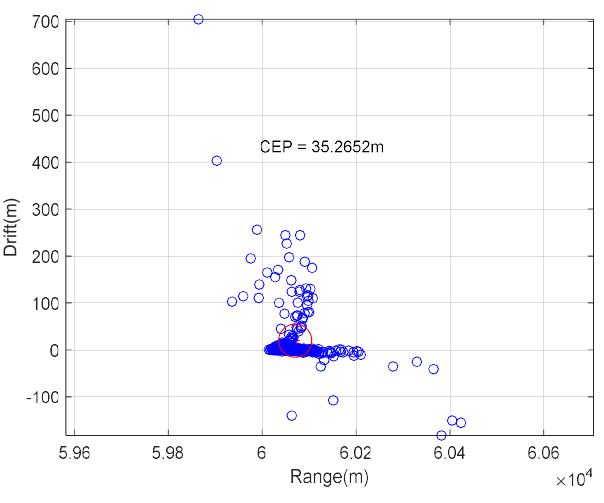
Figure 26. Guided Rocket CEP.